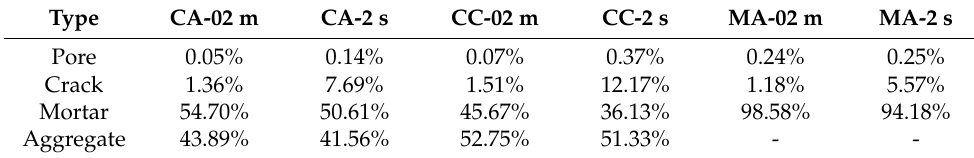
Table 2. Volume proportion of each